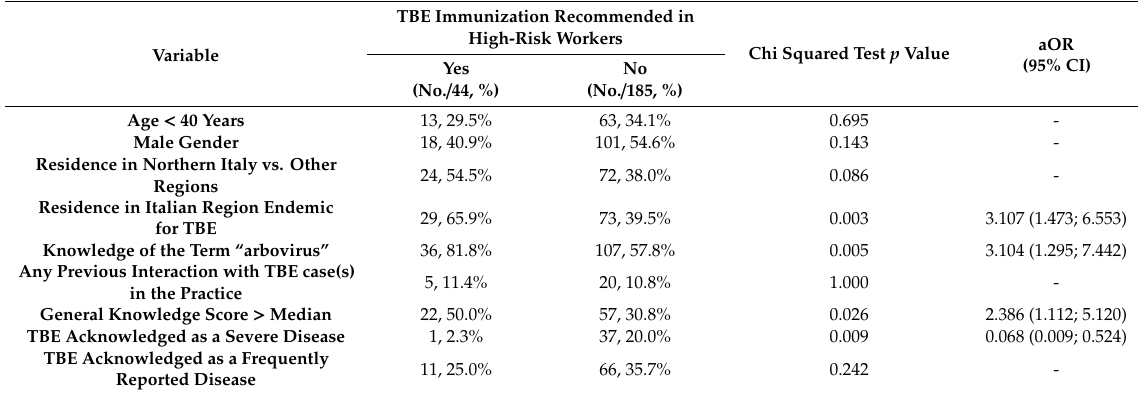
Table 3. Analysis of factors associated with promoting tick-borne encephalitis (TBE) vaccine in 229 Italian Occupational Physicians